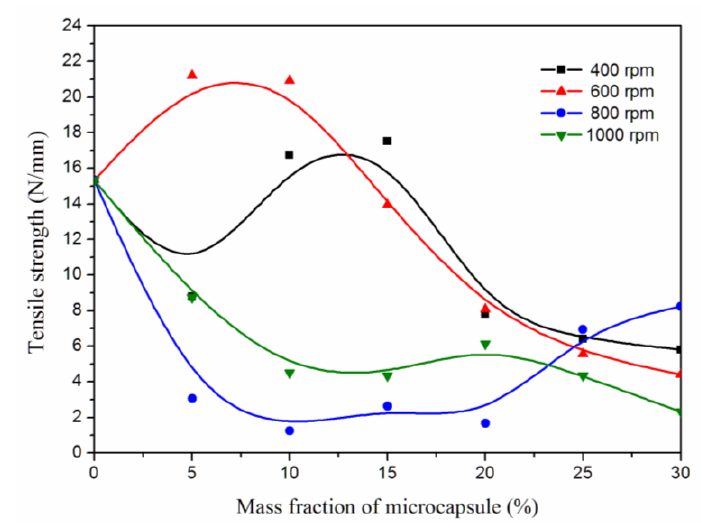
Figure 12. E ff ect of the mass fraction of microcapsules with di ff erent stirring rates on the tensile strength Figure 12. Effect of the mass fraction of microcapsules with different stirring rates on the tensile of water-based paint film. strength of water-based paint film.